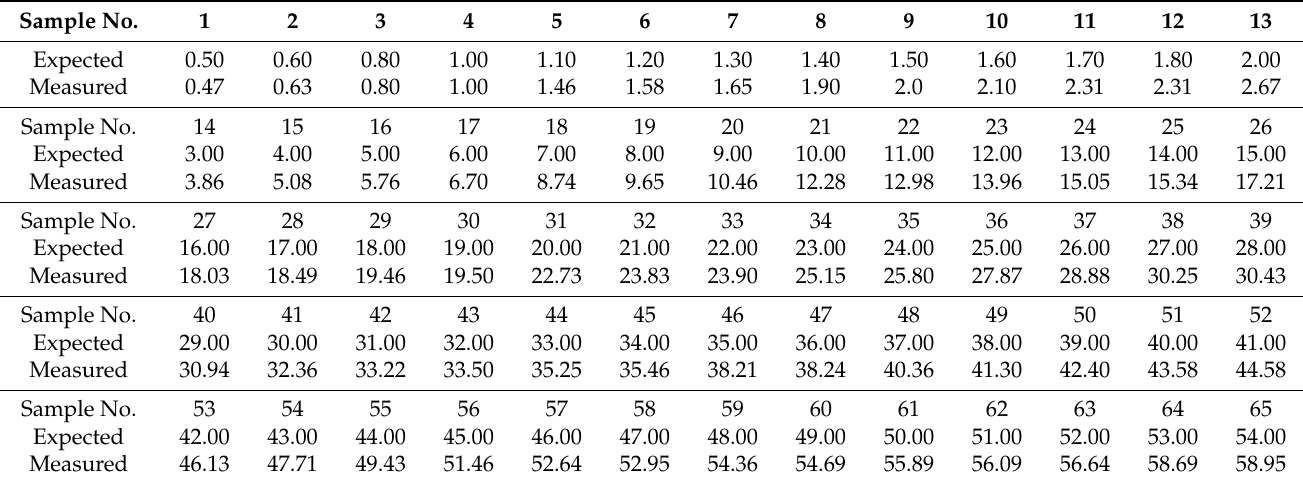
Table 1. Cd concentrations expected and measured of near standard soil samples